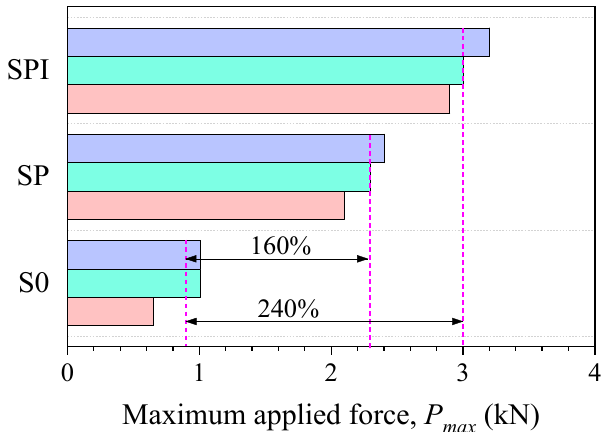
Figure 6. The maximum applied force measured in single shear tests.